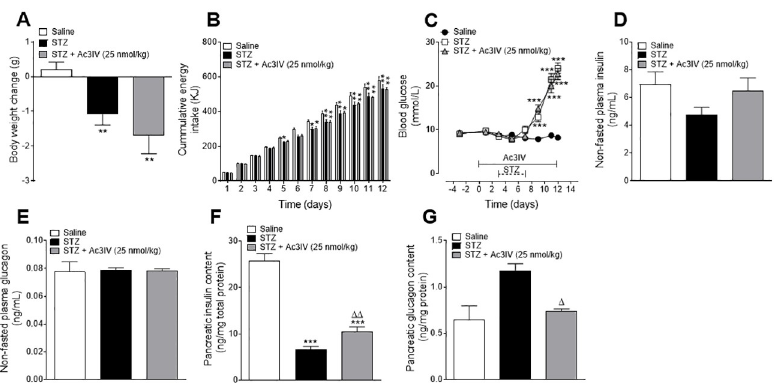
Fig 2. Effects of Ac3IV treatment on body weight, blood glucose, energy intake as well as circulating and pancreatic insulin and glucagon in STZ-diabetic Ins1Cre/+Rosa26-eYFP mice. Body weight change (A), cumulative energy intake (B) and circulating blood glucose (C) were measured during twice daily treatment with saline vehicle (0.9% NaCl) or Ac3IV (25 nmol/kg bw, i.p.) for 12 days in STZ- diabetic Ins1Cre/+Rosa26-eYFP transgenic mice. (D-G) Plasma and pancreatic insulin (D,F) and glucagon (E,G) levels were assessed on day 12. Solid lines parallel to x- axis indicate peptide treatment while dashed lines represent days of diabetes induction by STZ (C). Values are mean ± SEM for n = 6 mice. Values are mean ± SEM for n = 6 mice. � p < 0.05, �� p < 0.01, ��� p < 0.001 compared to saline vehicle. Δ p < 0.05, ΔΔ p < 0.01 compared to STZ control.